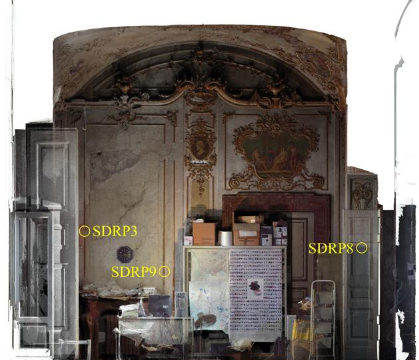
Figure 5. Laser scanner survey of the Gabinetto of gilded stucco. Wall 1 with sampling points.